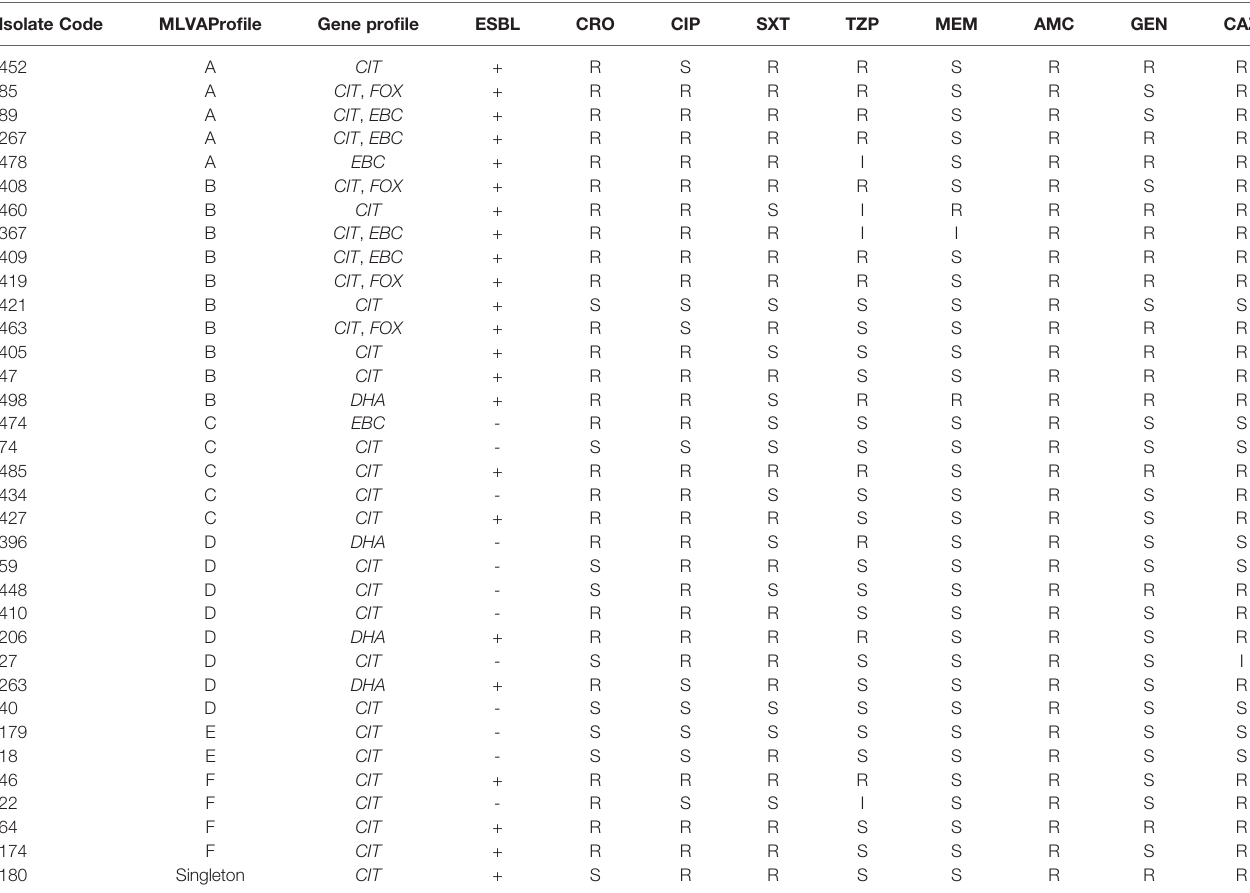
TABLE 3 | Characterization of AmpC Positive E. coli Isolates. Isolate